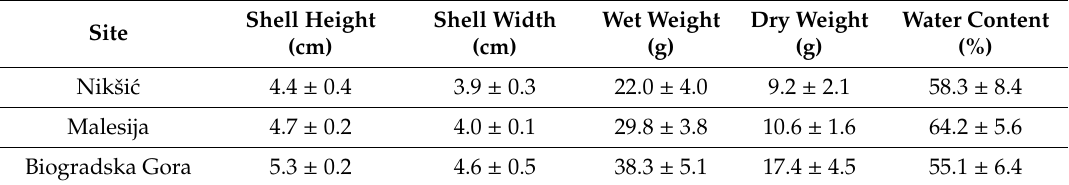
Table 1. Mean values (mean ± standard error) of water contents and other allometric parameters of the studied snail population.